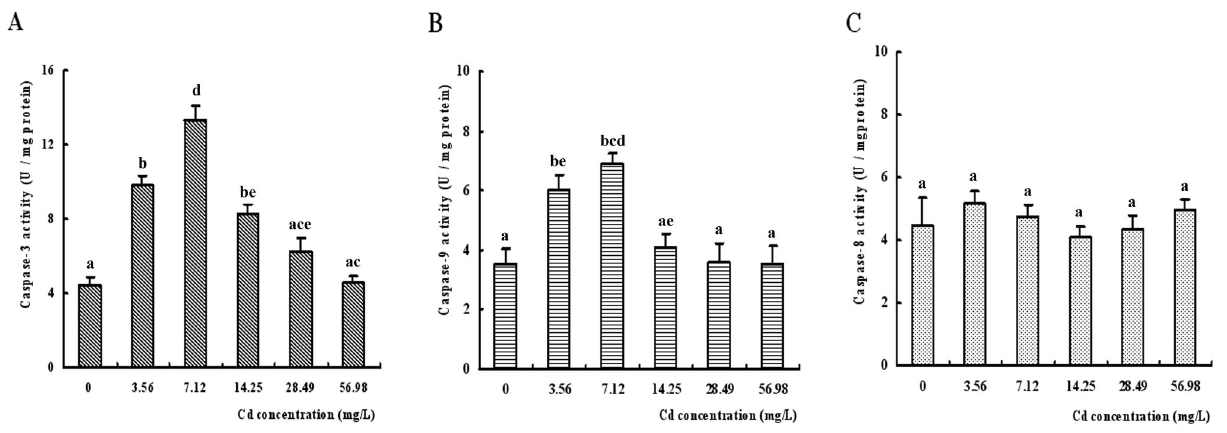
Figure 4. Effect of Cd on hepatopancreas caspase 3, 8, and 9 activities in S. henanense . ( A ) Caspase 3 activity ( n = 6). ( B ) Caspase 9 activity. ( C ) Caspase 8 activity (The different small letters were used to indicate the significant difference ( p < 0.05) between groups).